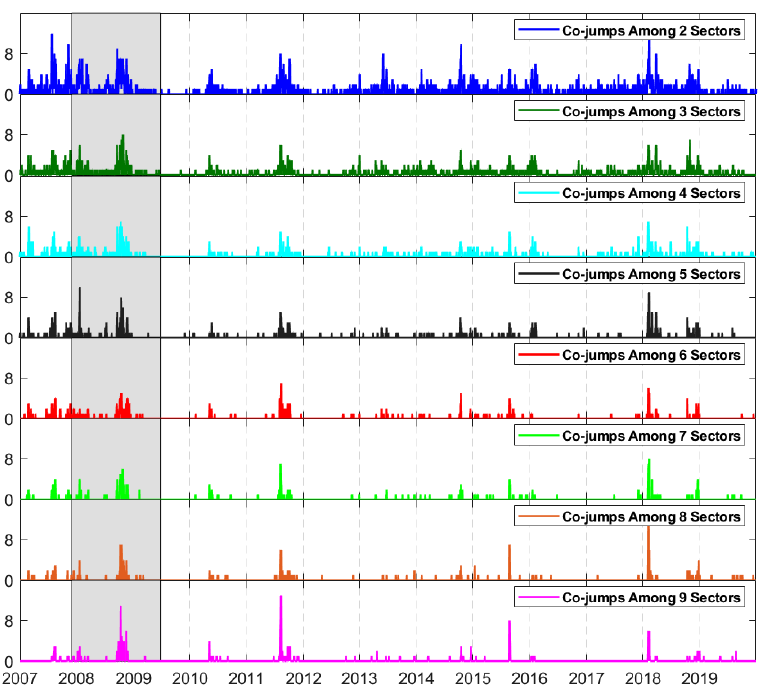
Figure 1. Number of co-jumps under different scenarios: Figure 1 shows the number of co-jumps identified under different scenarios, i.e., across nine sectors in the S&P 500 market from January 2007 to December 2019. The nine sectors are materials, energy, financial, industrial, technology, consumer staples, utility, healthcare, and consumer discretionary. The co-exceedance rule of the LM test is utilized to detect co-jumps among sectors. The shaded area in the figure denotes the financial crisis period from December 2007 to June 2009. See Sections 4 and 7 for further details.